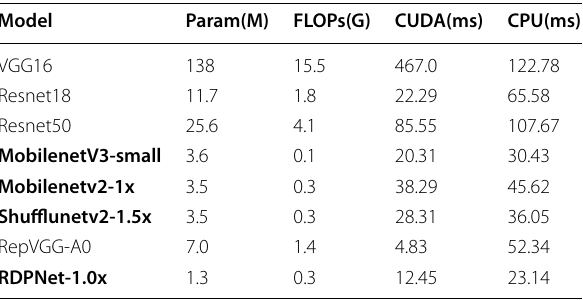
Table 1 The inference latency of different types of network structures on GPU and CPU